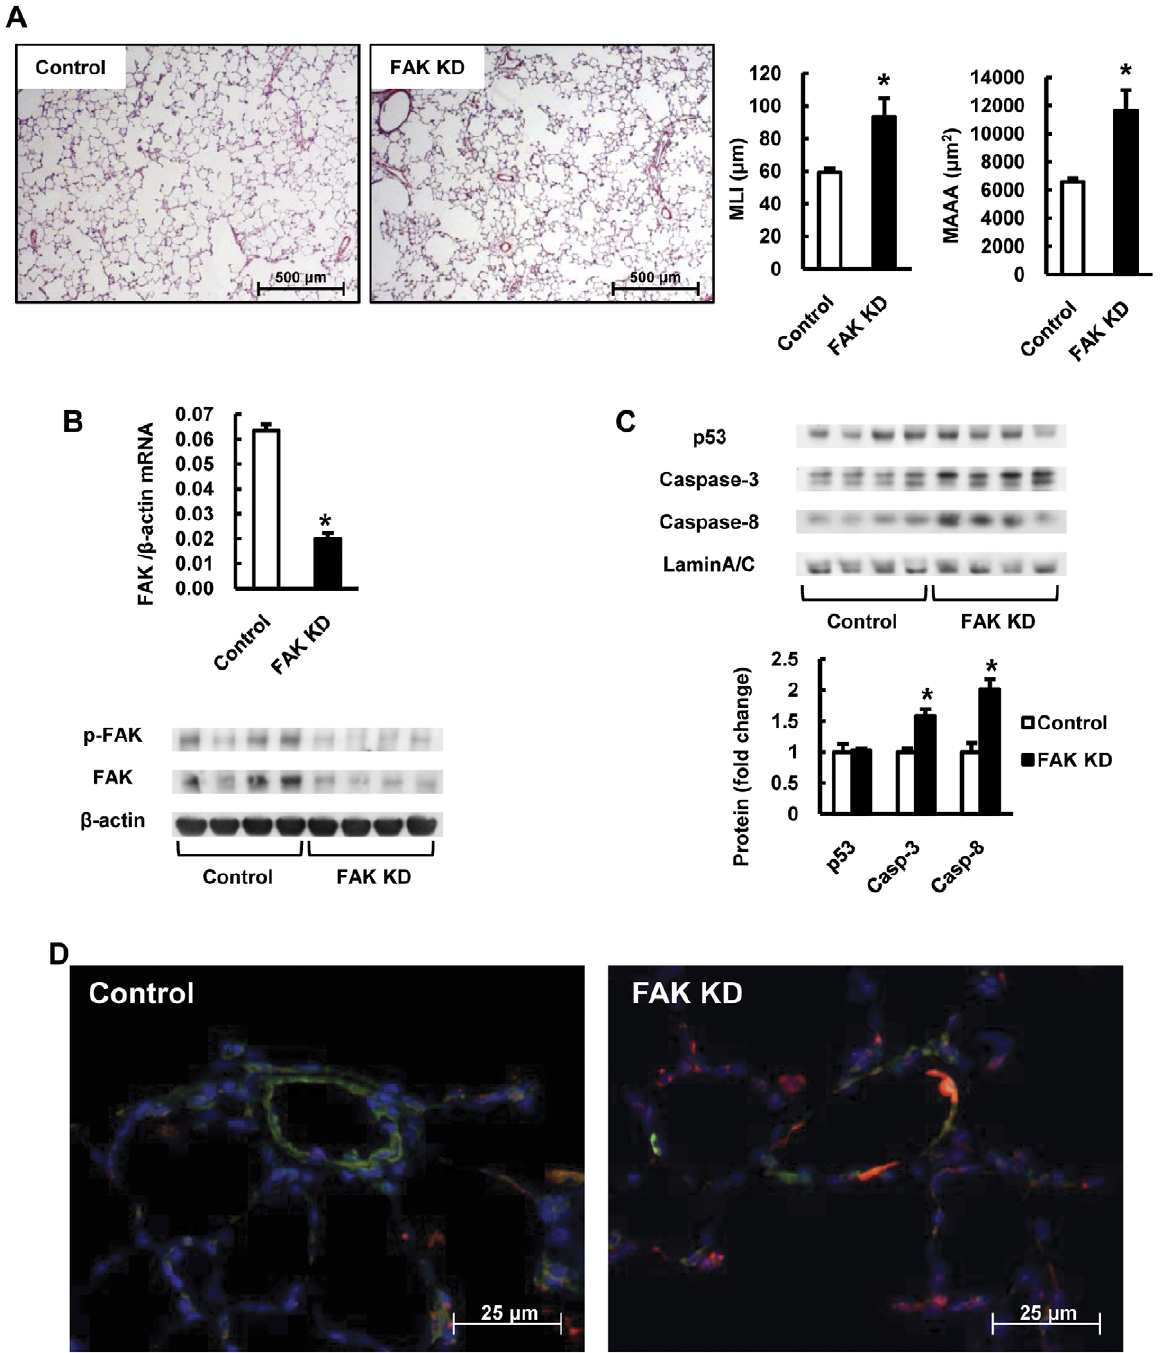
Figure 7. Invivo gene silencing of FAK causes emphysema and increases anoikis related protein expressions in rat lungs. (A) Representative photomicrographs of HE-stained lung sections of control and FAK siRNA treated rats. The bar graph shows quantification of MLI and MAAA in lung sections from control and FAK siRNA treated rats (FAK KD). (B) The bar graph shows the ratios of FAK mRNA expression relative to b - actin measured by RT-PCR. Representative Western blot analysis of phospho-FAK at Y397 site, FAK and b -actin in lung protein extracts from control and FAK siRNA treated rats. (C) Representative Western blot analysis of p53, caspase-3, caspase-8 and Lamin A/C in lung nuclear protein extracts from control and FAK siRNA treated rats. The bar graph shows the ratios of the protein expressions relative to control. Data are expressed as mean 6 SE (n=6). *P , 0.05 versus control. (D) Dual staining for Bim (red) and von Willebrand factor (vWF) (green) shows that the Bim positive cells are identified in and around the small pulmonary arteries from FAK siRNA treated (FAK KD) rat lungs. The blue color shows DAPI staining.